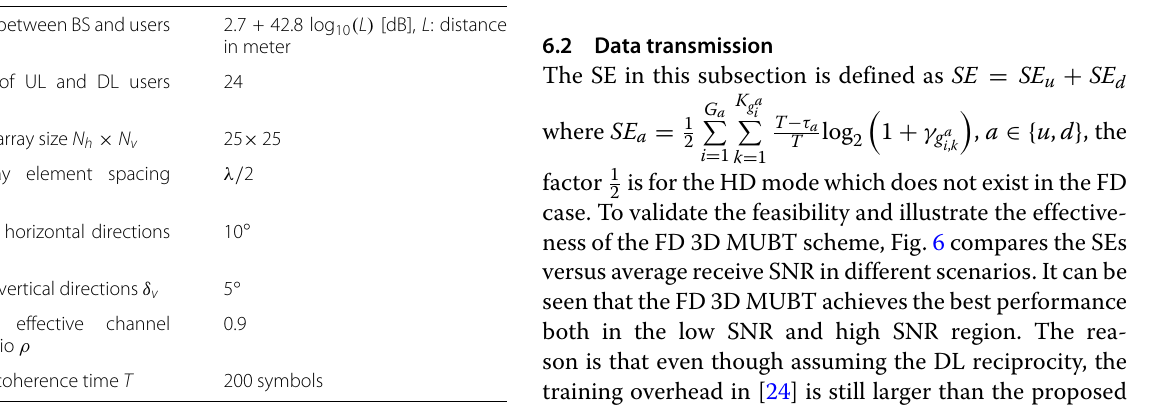
Table 1 Simulation parameters Parameters